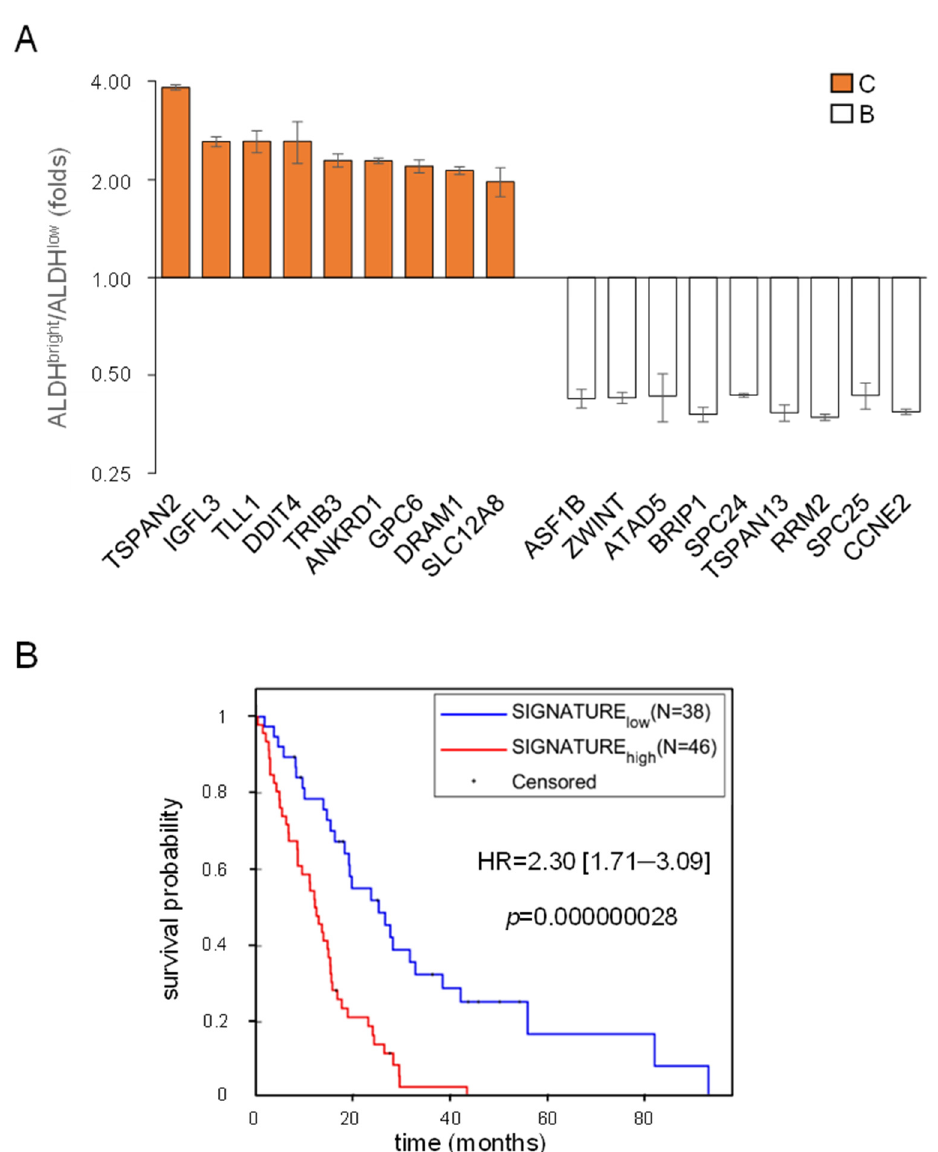
Figure 5. Identification of an eighteen-gene signature endowed with prognostic significance: ( A ) Histogram bars showing the levels of expression of 18 significantly modulated genes selected among the ALDH bright -enriched and those more deeply modulated by butein in the ALDH bright cells (Figures 2 and 3). Folds over ALDH low cells. ( B ) Kaplan–Meier plot showing the distribution of 84 MPM patients from TGCA based on the mean levels of expression of the eighteen genes. The p - and HR values are reported.